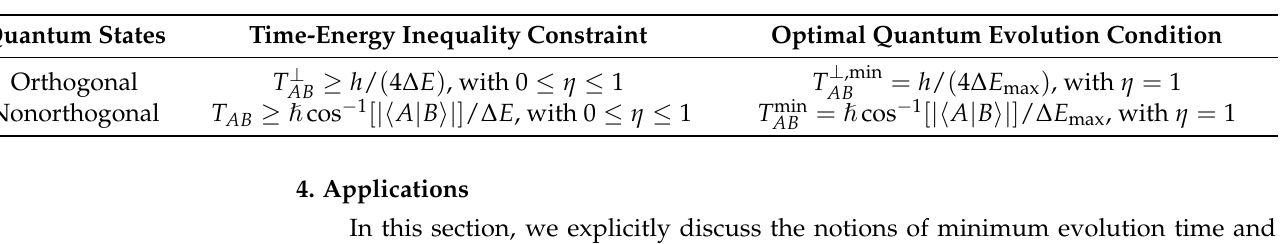
( geometric ) = 1 is only achieved when the time–energy QM